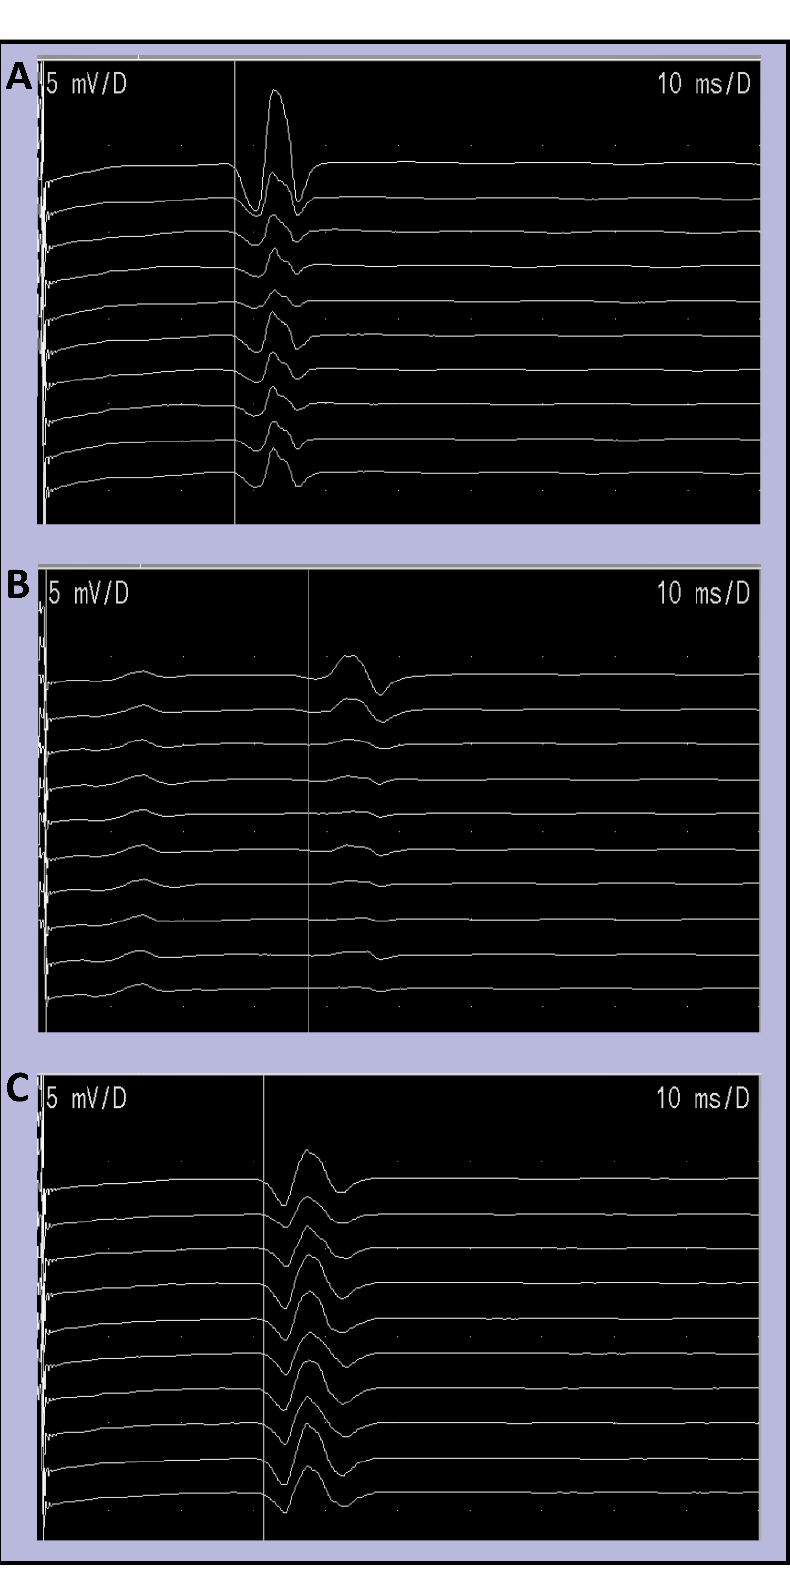
Figure 1. Example raw traces of H-reflex RDD in ( A ) healthy controls, ( B ) patients with diabetes without neuropathic pain, and ( C ) patients with diabetes with neuropathic pain.